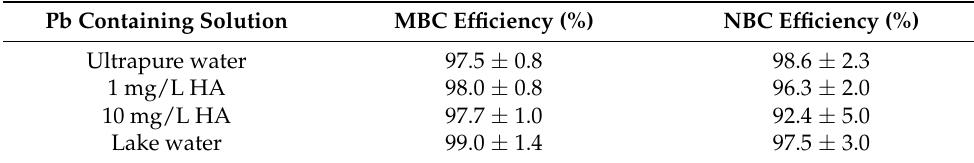
Table 3. Adsorption efficiencies of the two biochar materials at varying HA concentrations and in lake water spiked sample.